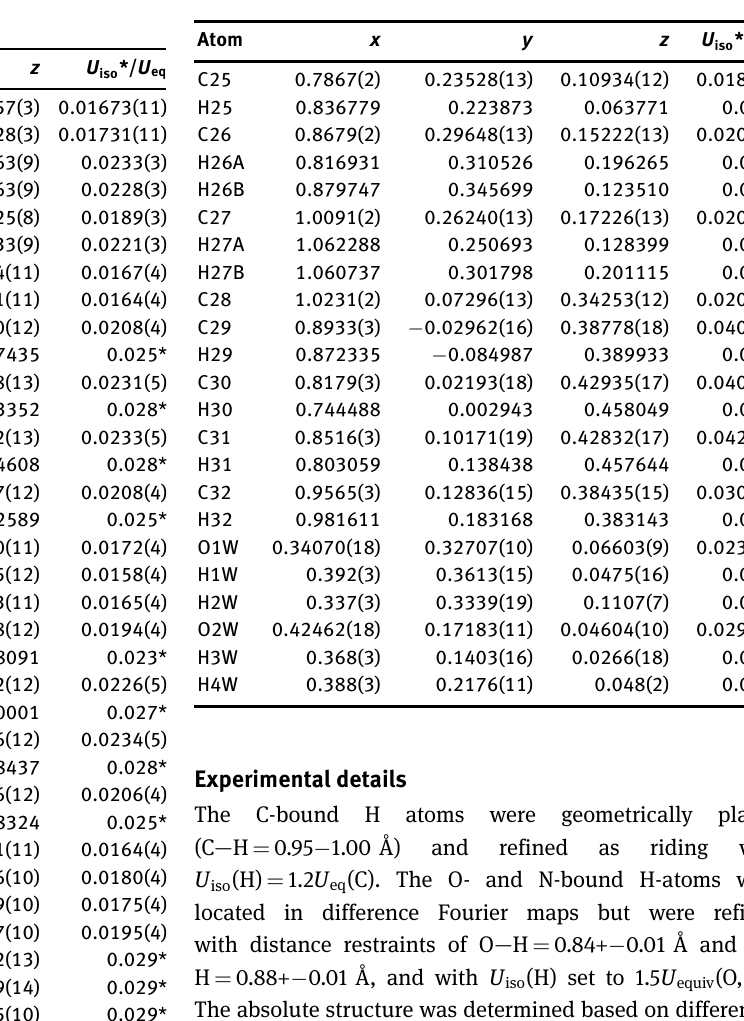
Table 2: Fractional atomic coordinates and isotropic or equivalent isotropic displacement parameters (Å 2 ).